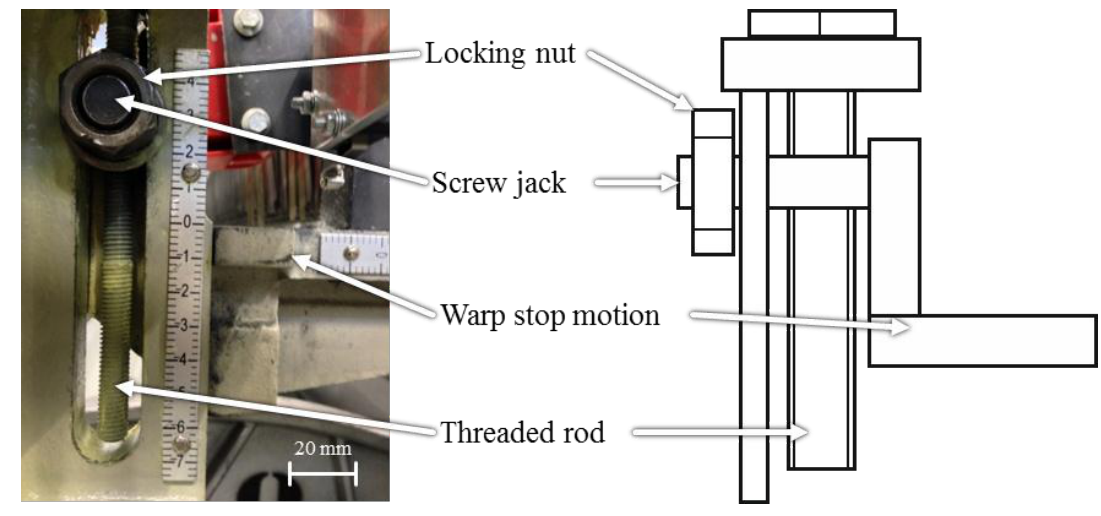
Figure 4. Vertical warp stop motion adjustment on an OmniPlus 800 air jet-weaving machine from Picanol NV, Ieper,